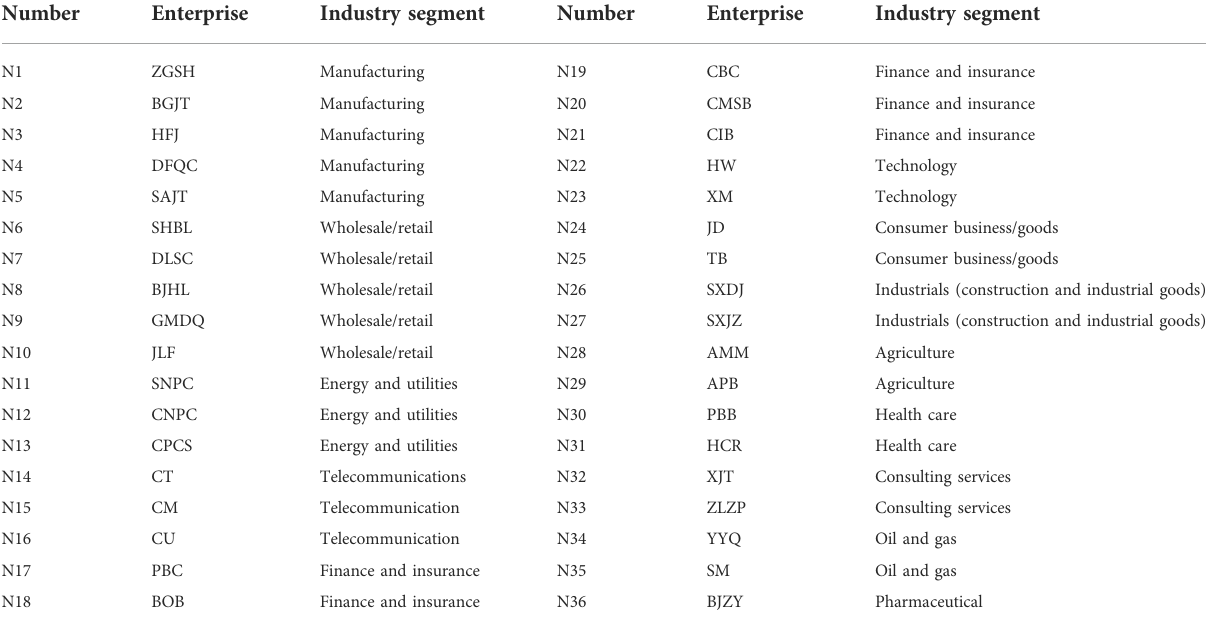
TABLE 1 Basic information of sample